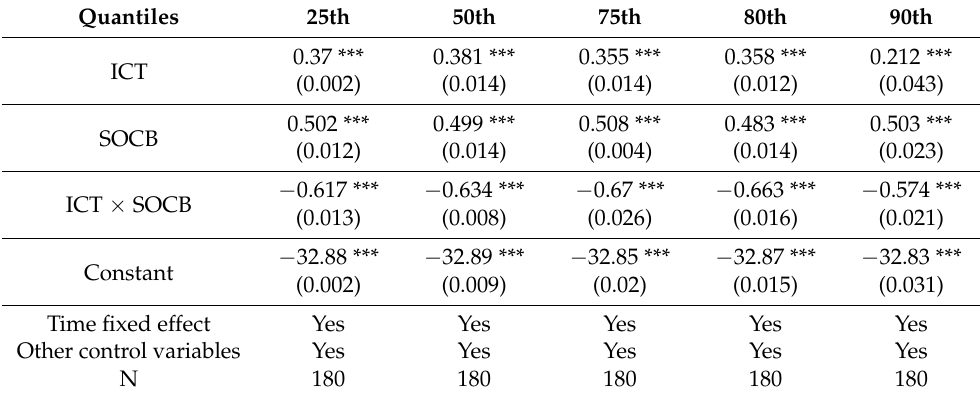
Table 5. The results of interaction terms between ICT and bank ownership. Quantiles